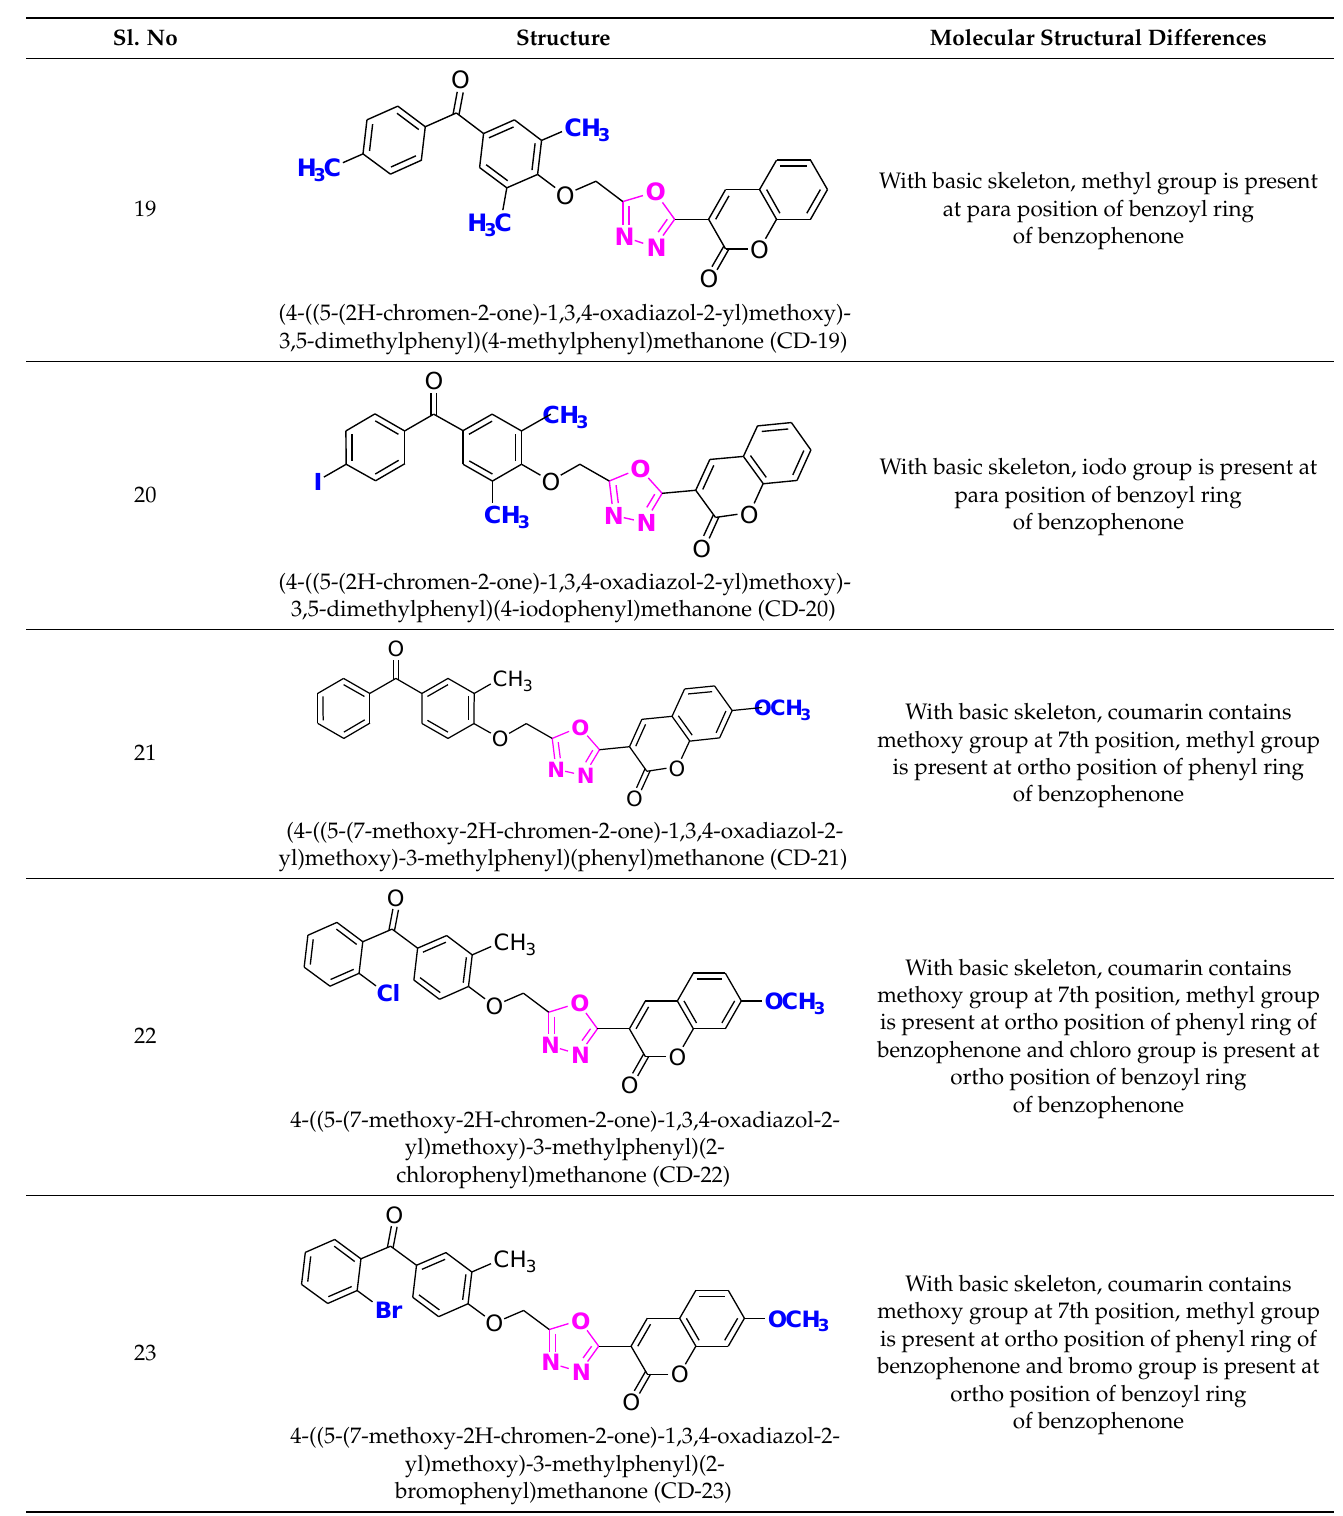
With basic skeleton, methyl group is present at para position of benzoyl ring of